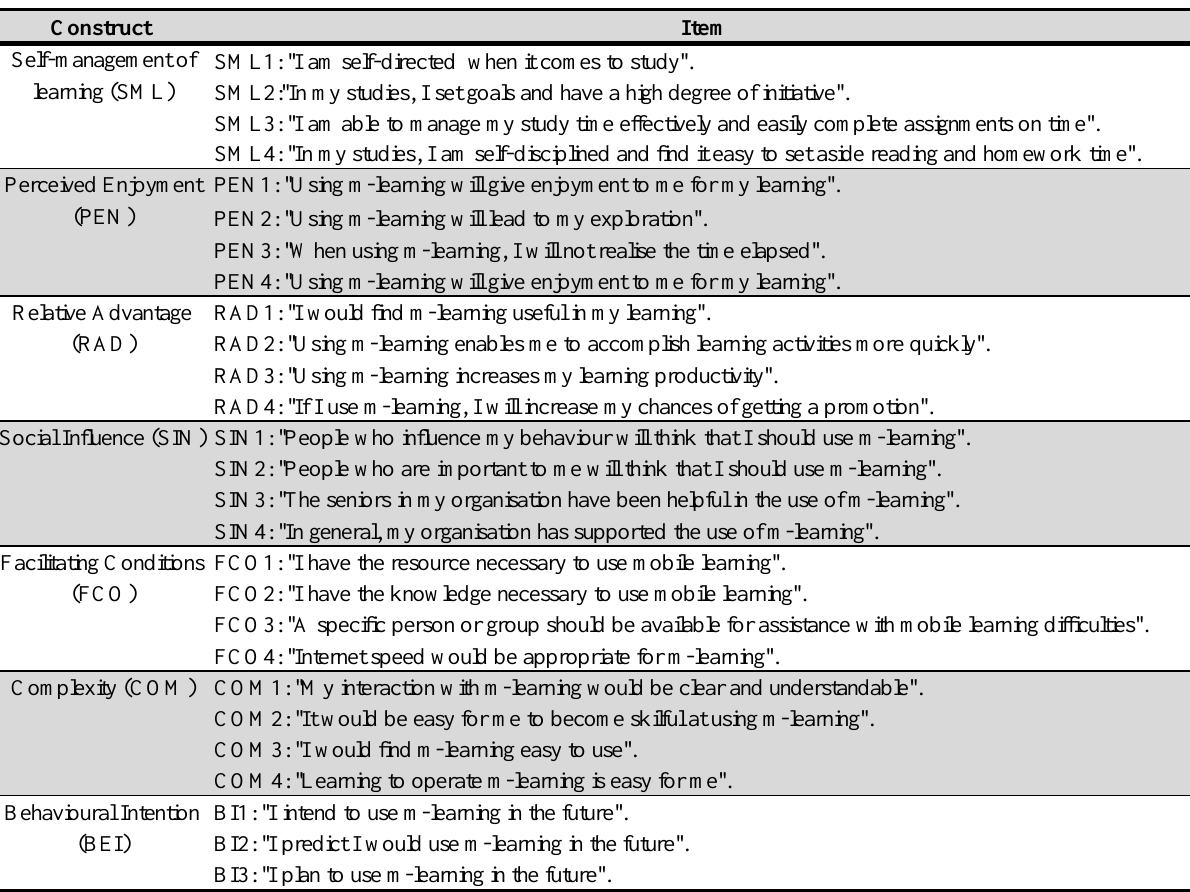
The Questionnaire